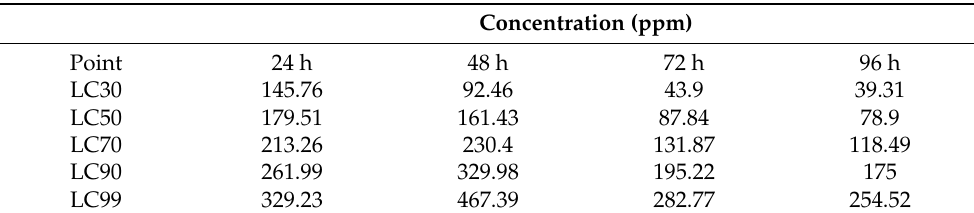
Table 2. Lethal concentrations of green synthesized ZnO-NPs at different time points of 24, 48, 72, and 96 h.